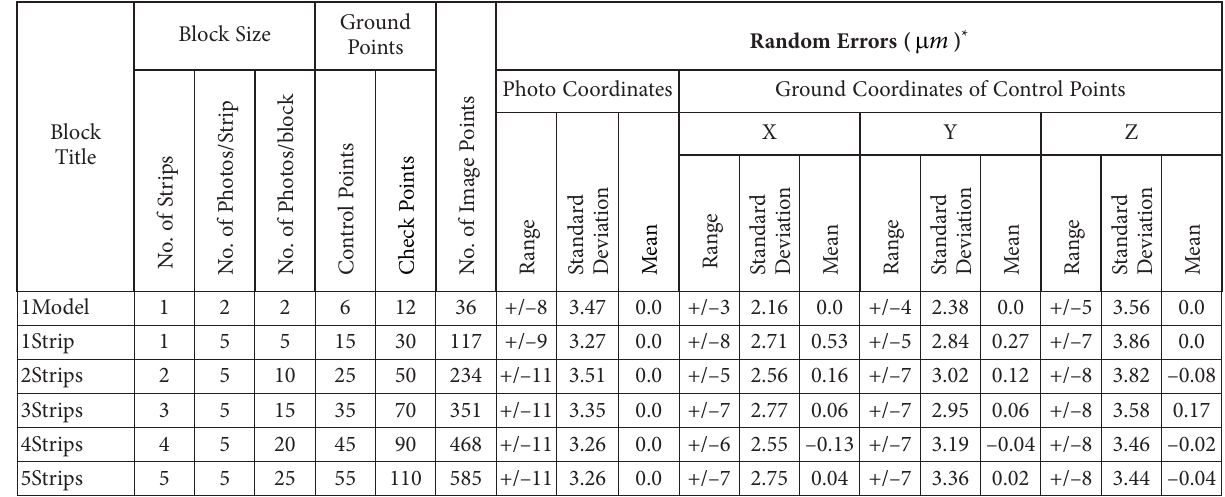
Table 1. The configurations for mathematical photogrammetric blocks of